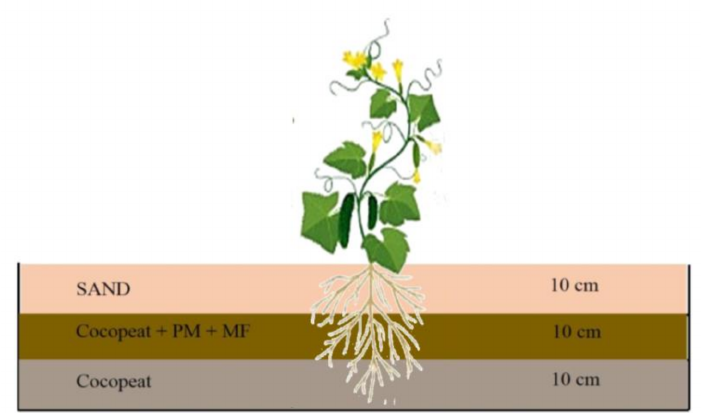
Figure 1. The schematic design three layers of the trough. The bottom layer contained coco-peat, the top layer contained sand, and the middle layer was used for different treatments of the combination of coco-peat, MF, and poultry manure (PM) except T1, which was used as control comprising only 60 kg of